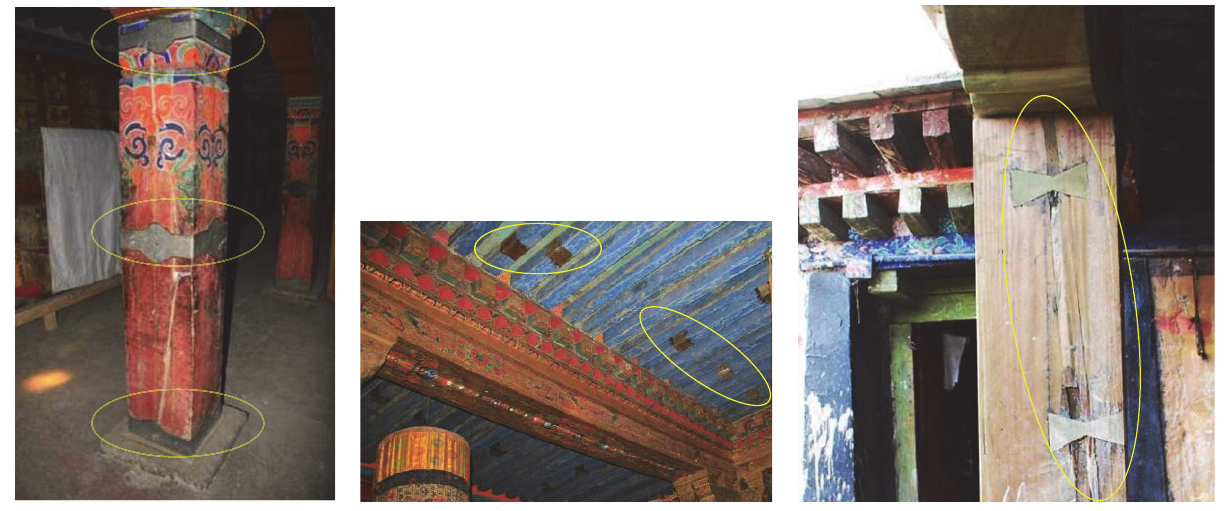
Figure 20: Rehabilitation methods for structural components with cracks.